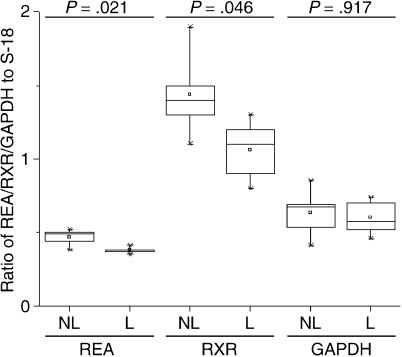
Validation of the Microarray Findings by RT-PCRRelative abundance of mRNA, normalized to S-18, encoding the gene for REA, RXR, and GAPDH in the myometrium obtained from the uterine fundus in five non-laboring (NL) and five spontaneously laboring (L) patients. Box limits represent 25th and 75th quartiles, line within the box represents median, and whiskers represent 5th and 95th percentiles.